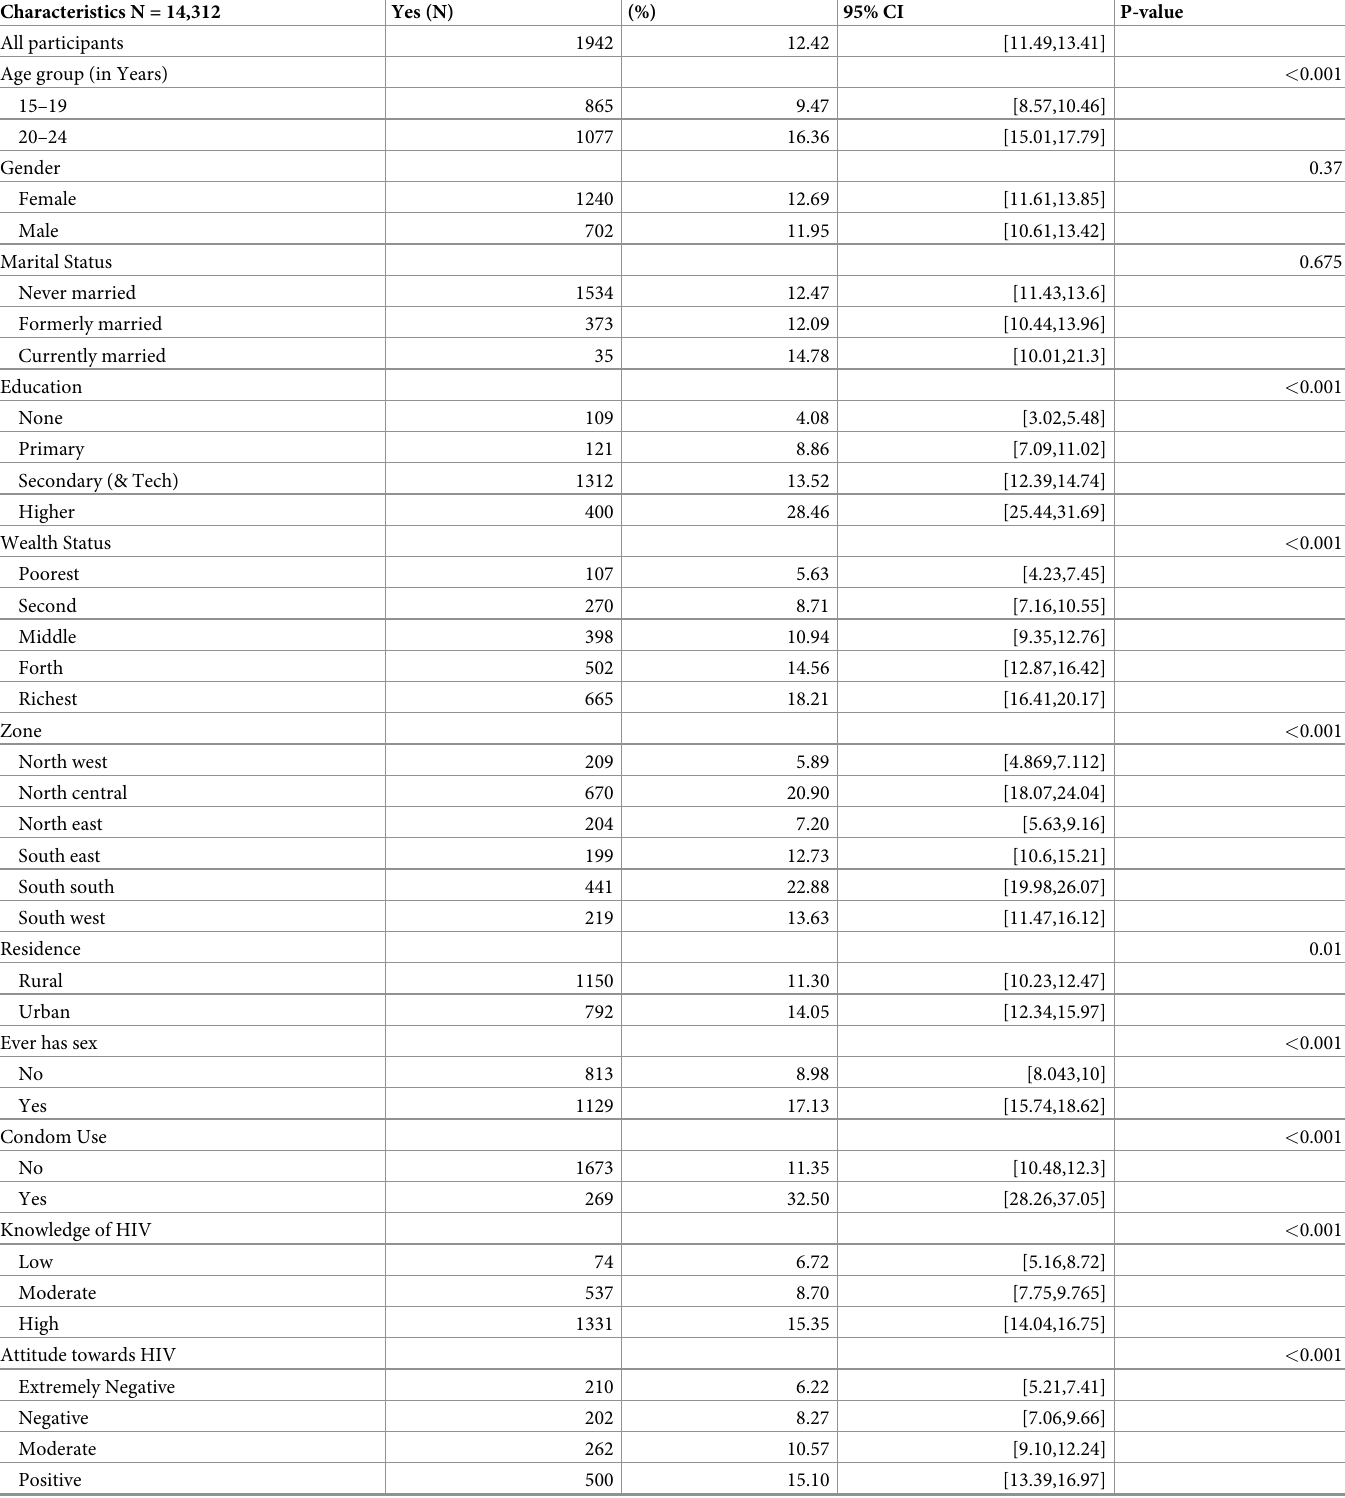
Table 3. Weighted proportions of adolescents recently tested for HIV by demographic, behavioural, social and contextual factors. Characteristics N =